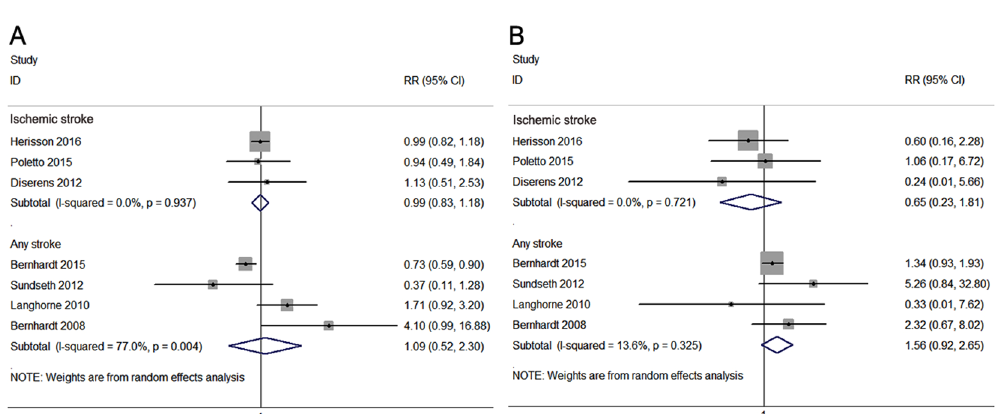
Figure 4. Forest plots of primary efficacy and safety outcomes stratified by stroke type. The diamond indicates the estimated relative risk (RR) (95% confidence interval). The p-value showed on each figure is for heterogeneity test. Modified Rankin Scale (0–2) at 3 months: ischemic stroke, p for overall effect = 0.90, Q = 0.13; any stroke, p for overall effect = 0.82, Q = 13.07 (A) . Mortality at 3 months: ischemic stroke, p for overall effect = 0.40, Q = 0.65; any stroke, p for overall effect = 0.10, Q = 3.47 (B)